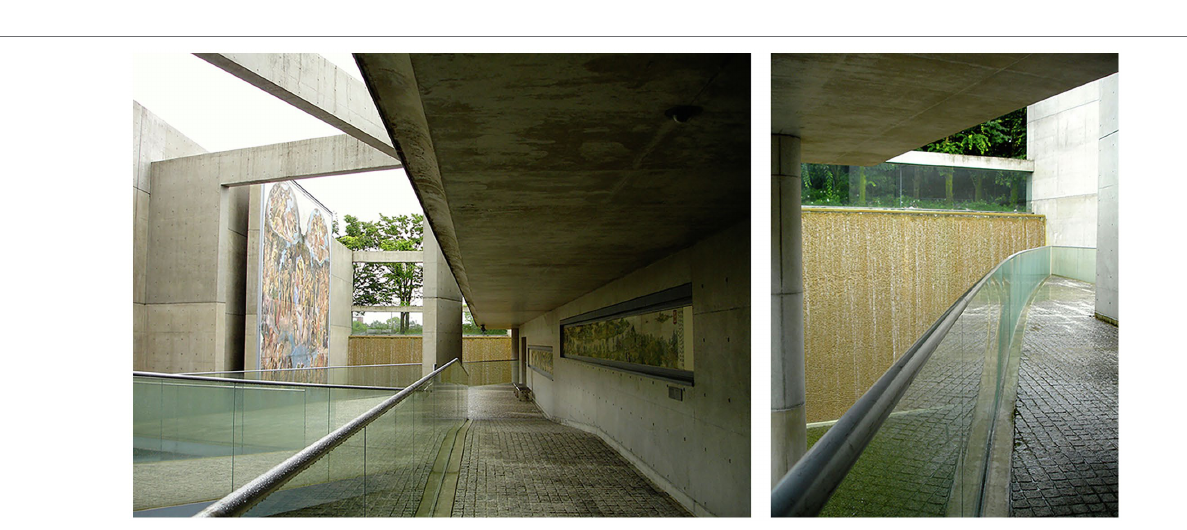
FIGURE 3 | Outdoor gallery viewed from the lower level (left) and a cascade viewed from an elongated ramp (right). Garden of Fine Arts, Tadao Ando, Kyoto, Japan. Photo credit: Jain